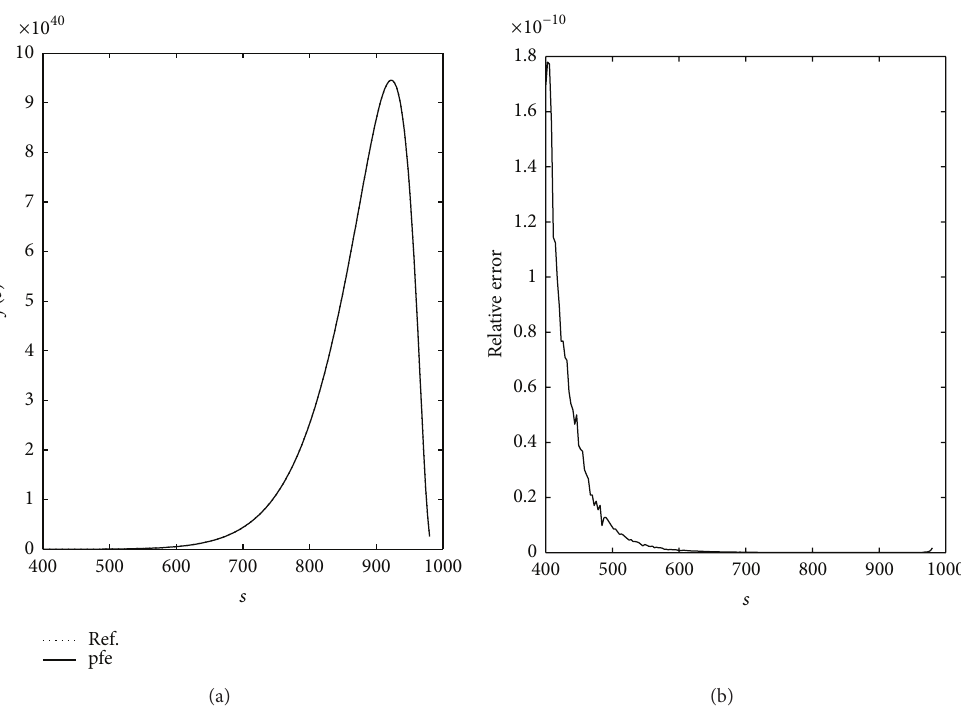
Figure 3: Comparison of pfe with reference solution (a) and relative error of pfe (b) in Example